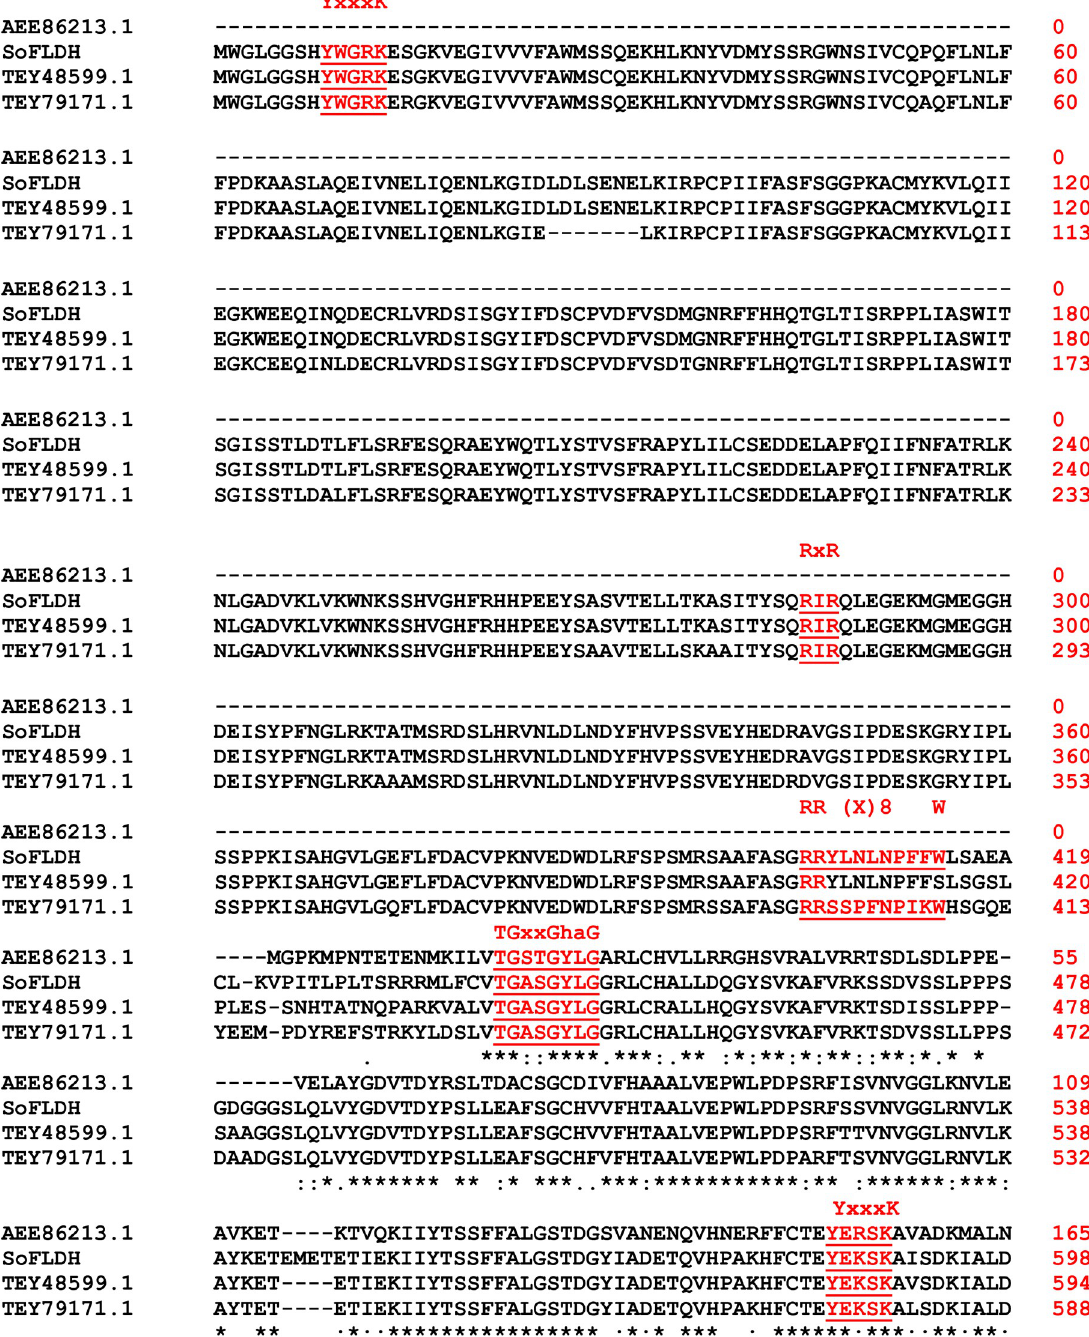
PLOS ONE | https://doi.org/10.1371/journal.pone.0269045 June 3,